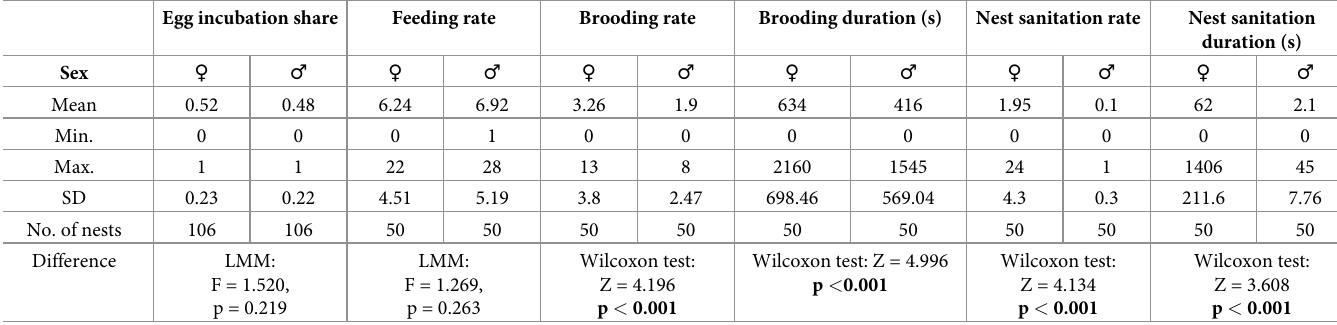
Table 1. Blackcap male and female participation in parental care. Egg incubation